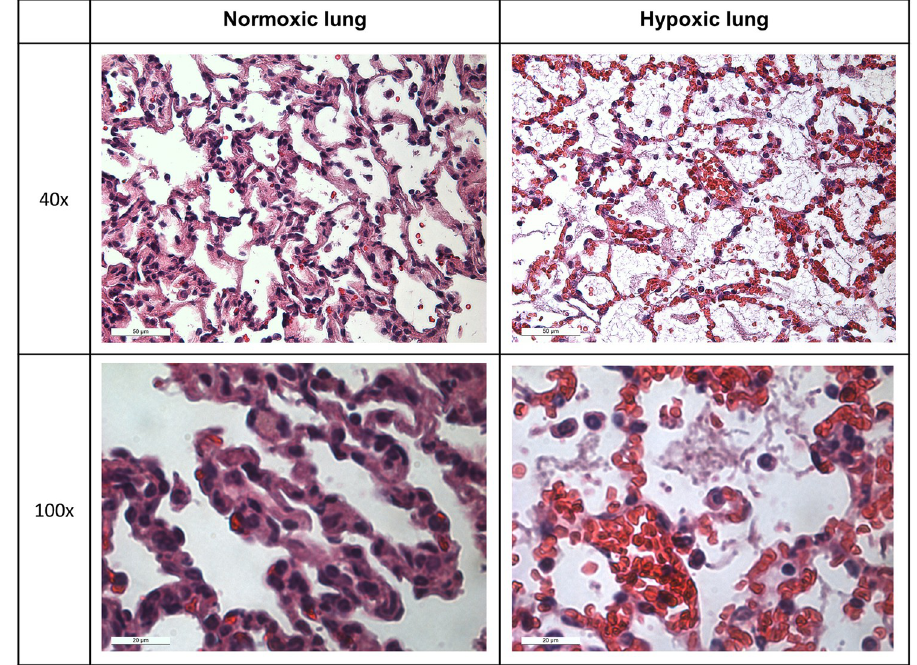
Fig 4. Exemplary histological images of lung tissue from both hypoxic and normoxic rats in 40x and 100x magnifications. The images of the hypoxic lung show intra-alveolar fibrin depositions and increased interstitial erythrocytes. Both changes indicate increased vascular permeability in hypoxic